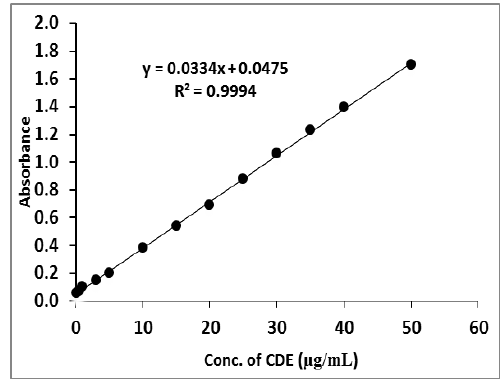
Figure 6. Calibration curve. Table 2. Summary of characteristics data